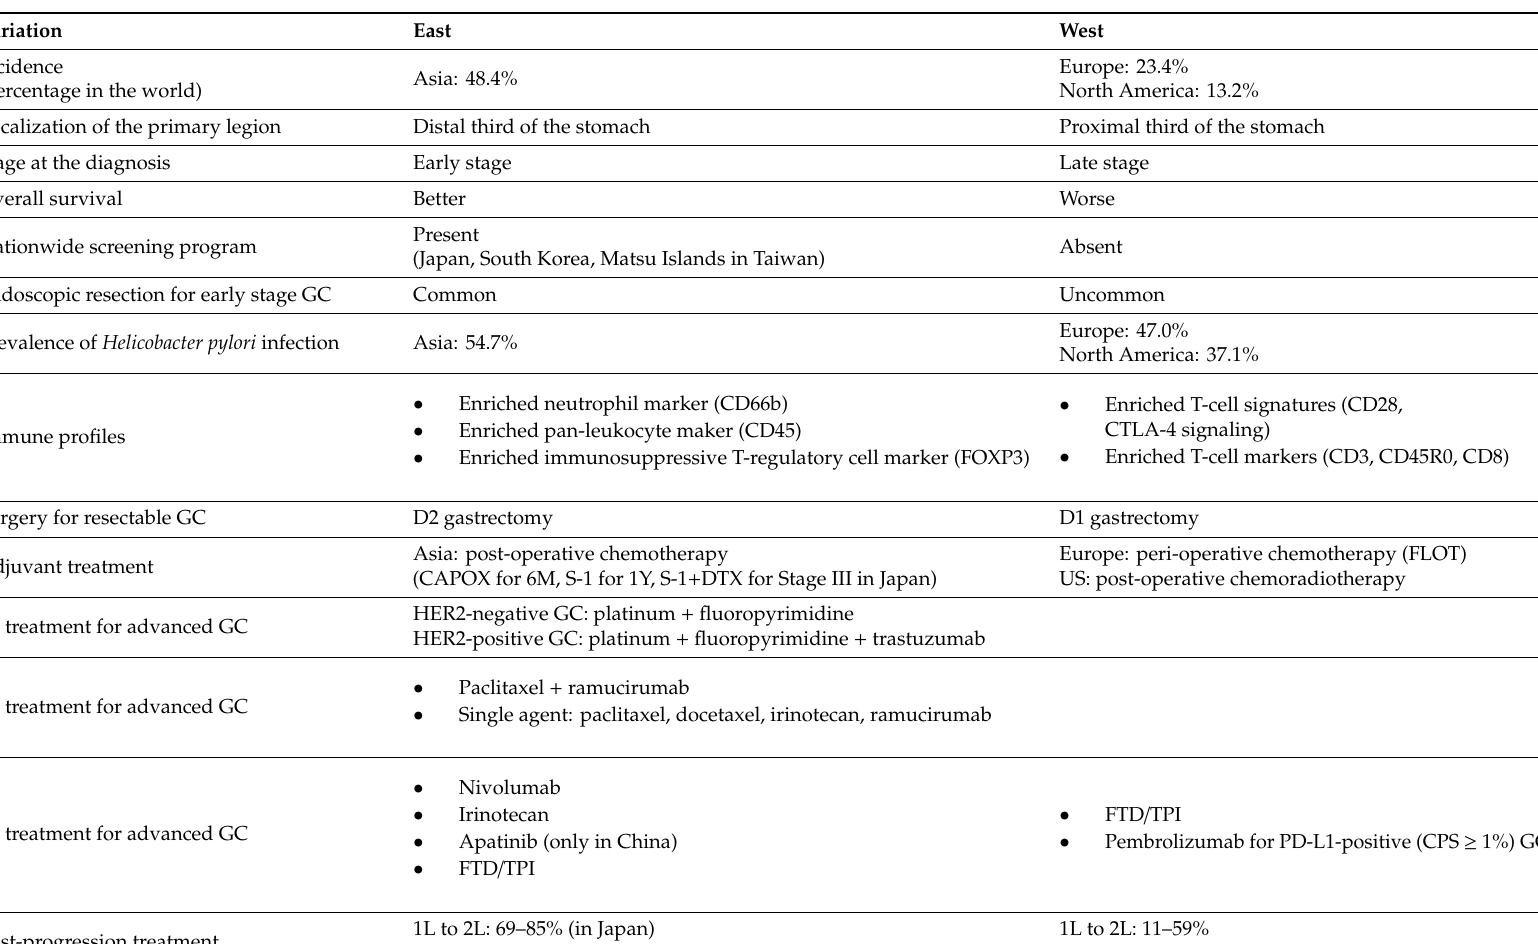
Table 5. Di ff erences in epidemiology, biology, and clinical practice between the East and the